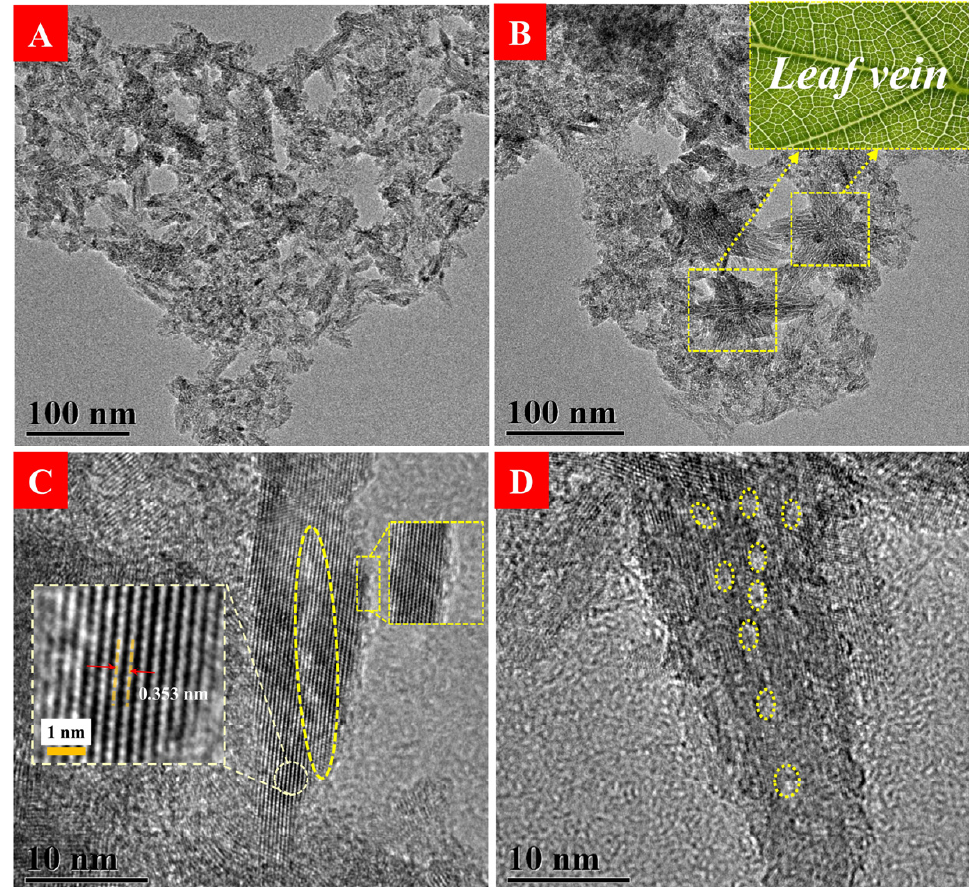
Figure 3. ( A ) Low magnification TEM images of HAm-TiO 2 − x . ( B ) The leaf-vein-shaped nanoparticles in HAm-TiO 2 − x , the inset was a photograph of the leaf vein. ( C ) The curve-like bulk defect marked with yellow oval and the disordered surface marked with yellow rectangle; the crystal plane spacing (d-spacing) was calculated to be 0.353 nm as shown in the left dotted box. ( D ) Some mesoporous structures marked with yellow circles in HAm-TiO 2 − x .